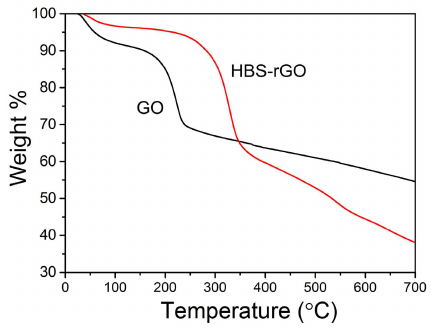
Figure 7. Thermogravimetric analysis (TGA) measurements of GO and